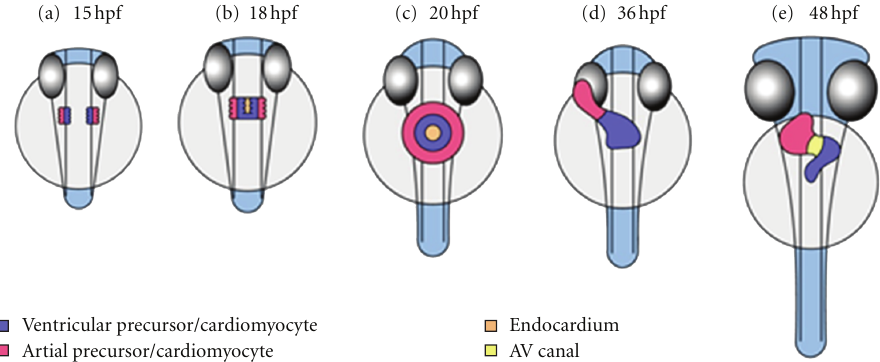
Figure 1: Stages of heart development in zebrafish embryos in a ventral view. (a) At 15hpf cardiac precursors move towards the anterior lateral plate mesoderm; the atrial precursors are located laterally, the ventricular precursors medially. (b) Cardiac fusion starts at about 18 hpf at the posterior end of the bilateral heart fields; first, endocardial cells arrive at midline, followed by ventricular cells. The atrial precursors do so slightly later. (c) After cardiac fusion the cells form the cardiac cone. Viewed ventrally, this structure resembles a ring: endocardial cells lining the central lumen, and ventricular cells are surrounded by atrial precursors. The cardiac cone starts to transform into the heart tube by 21hpf. (d) Cardiac looping of the heart tube occurs between 26hpf and 48hpf. The linear heart tube bends and creates an S-shaped loop. By 36hpf the atrium and ventricle become distinguishable. (e) The heart tube rotates. The di ff erent parts of the heart tube do not rotate equally and therefore torsion occurs. The AV canal develops by constriction of the boundary between atrium and ventricle. Ventricular maturation by appositional growth takes